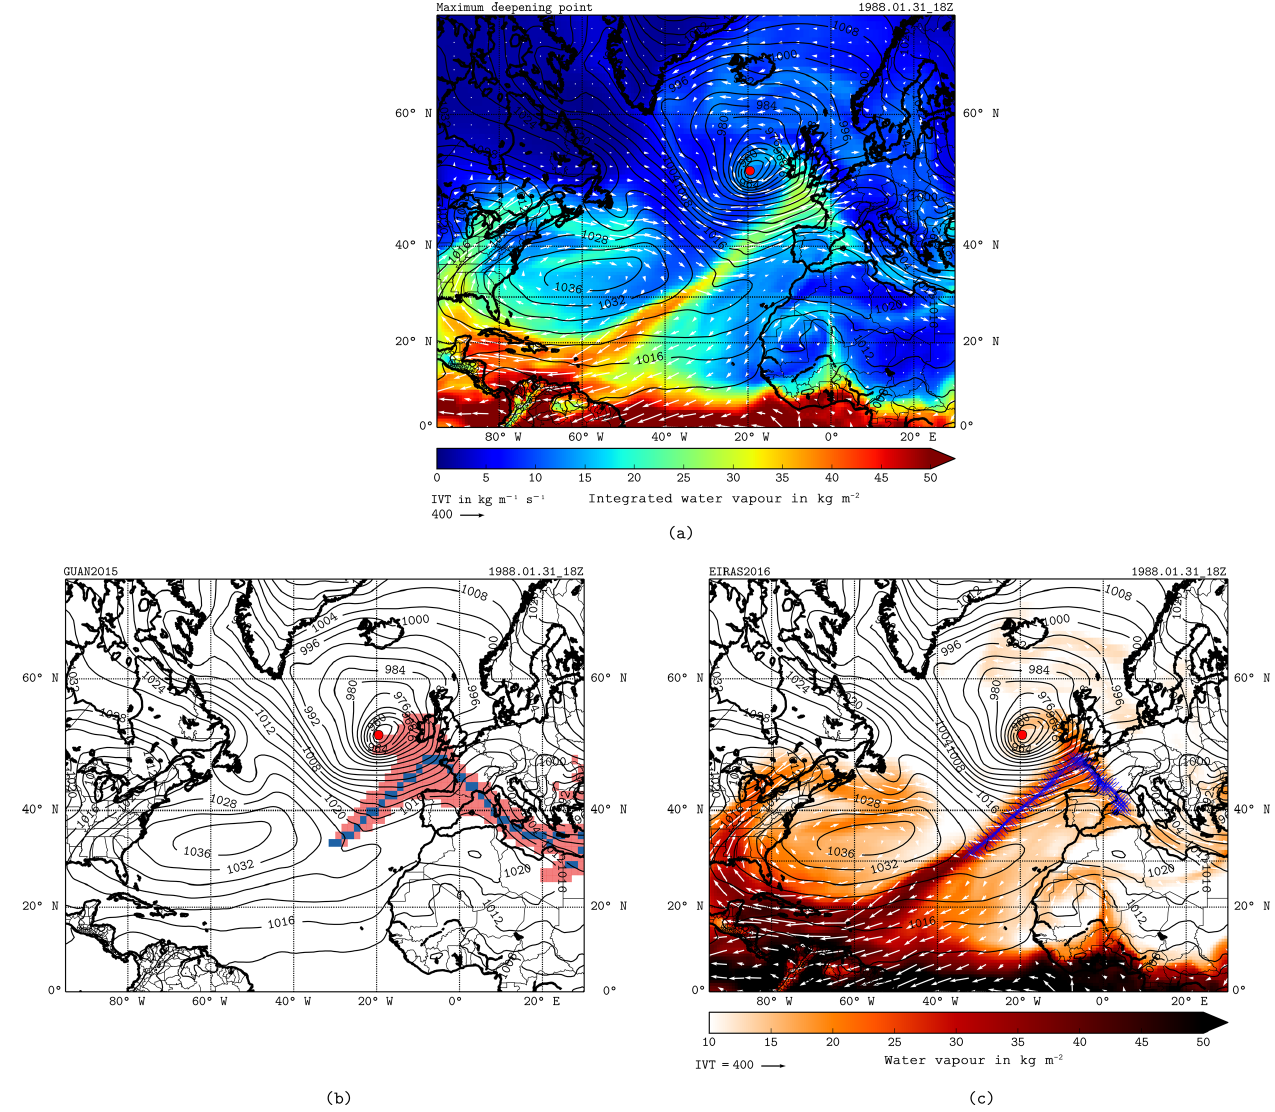
Figure 2. Example of a well-defined atmospheric river associated with an explosive cyclone development making landfall over the British Isles on 31 January 1988, 18:00UTC. Mean sea level pressure field (hPa) is indicated as black isolines in all panels. (a) Total integrated column of water vapour (IWV, colours, kgm − 2 ) and integrated vapour transport (IVT, arrows, kgm − 1 s − 1 ). (b) Shape region (red) and central axis of the atmospheric river (blue) for the GUAN2015 algorithm. (c) As (a) but showing only IWV values above 10kgm − 2 ; the blue crosses highlight the central axis of the atmospheric river detected by the EIRAS2016 algorithm. In addition the location of the MDP is highlighted with a red